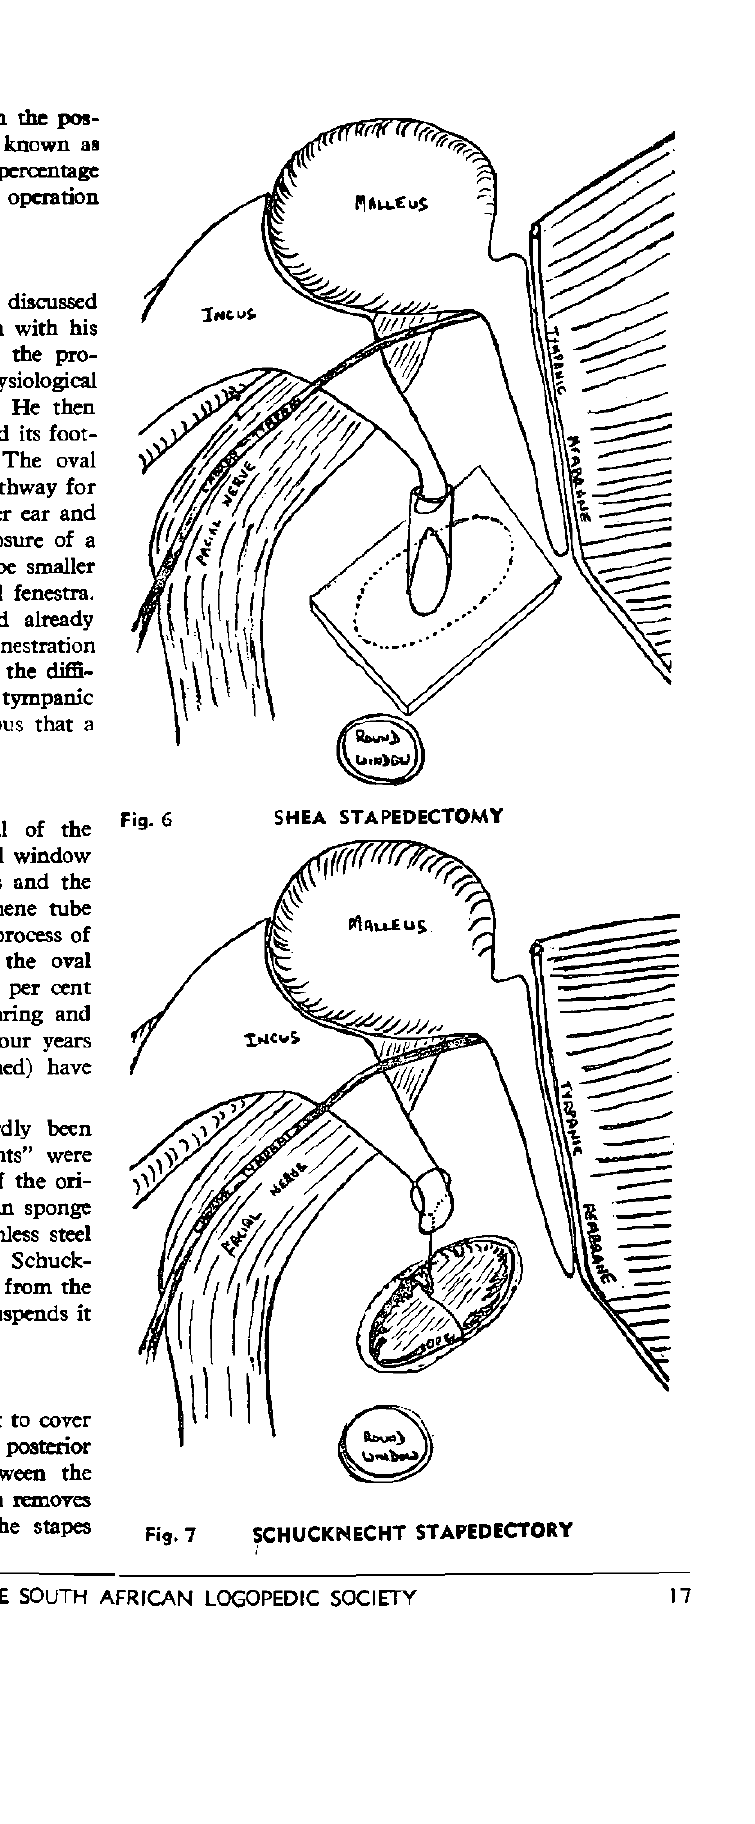
SCHUCKNECHT STAPEDECTORY